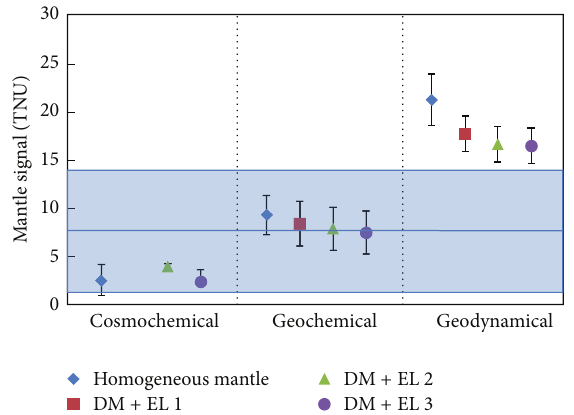
Figure 11: The measured geoneutrino signal from the Borexino + KamLAND combined analysis under the assumption of a spheri- callysymmetricmantle(see(13))iscomparedwiththepredictionsof different Earth’s models from [14]. The three DM + EL distributions of the HPE elements in the mantle correspond to the depleted mantle compositions from [36–38], respectively.